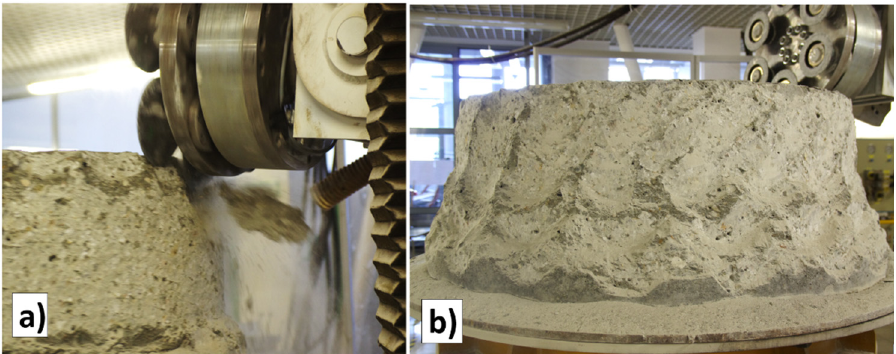
Figure 20. The view of the sample: ( a ) during mining at the chipping depth of 15 mm, ( b ) the surface after mining at the chipping depth of 15 mm.